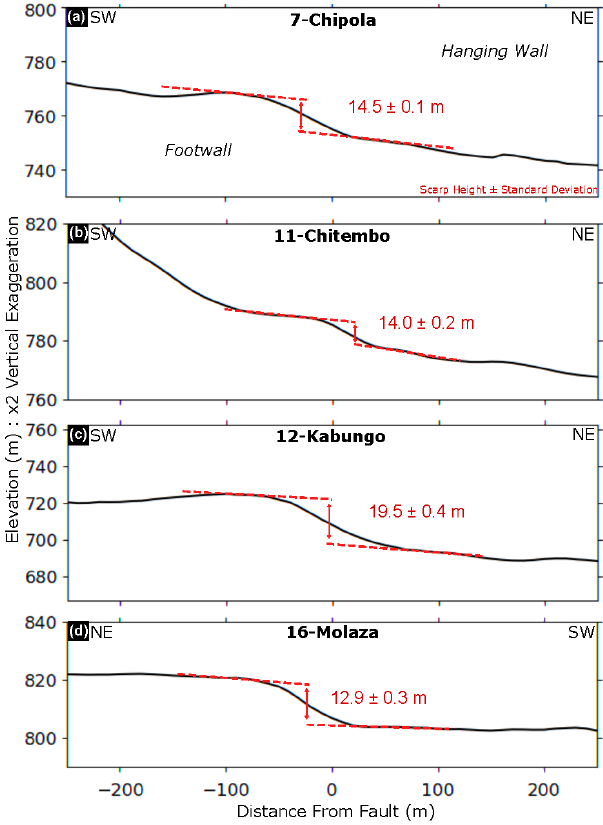
Figure 9. Example topographic profiles measured across faults in the Luangwa Rift showing the Chipola (a) , Chitembo (b) , Kabungo (c) , and Molaza (d)